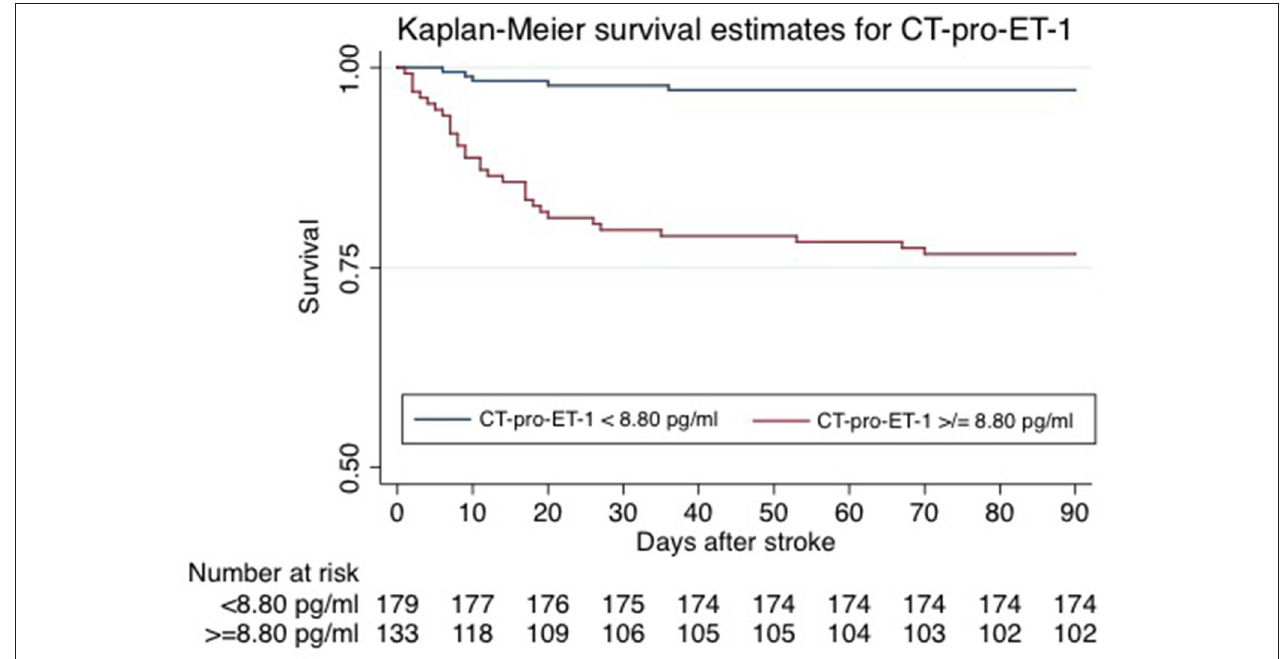
FIGURE 3 | Kaplan-Meier survival estimates of patients stratified by CT-pro-ET-1 on day 1 after admission. Kaplan-Meier survival curves of patients stratified per CT-pro-ET-1 cut-off levels < 8.80 and ≥ 8.80 pg/ml differed significantly ( p = < 0.001, log-rank